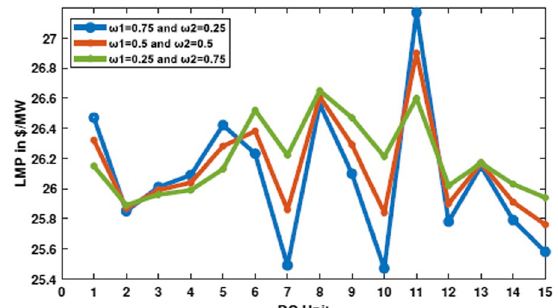
Fig. 4 Impact of ω 1 and ω 2 on the DG unit’s LMP